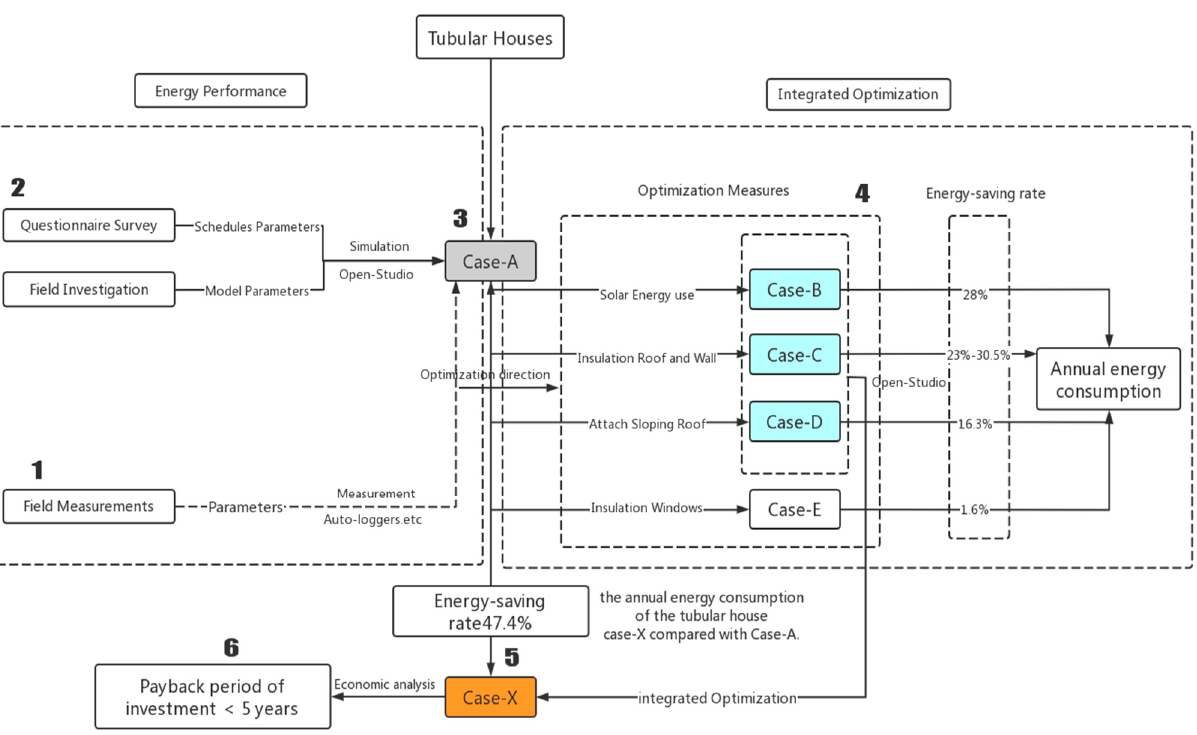
Figure 2. Research methods framework.